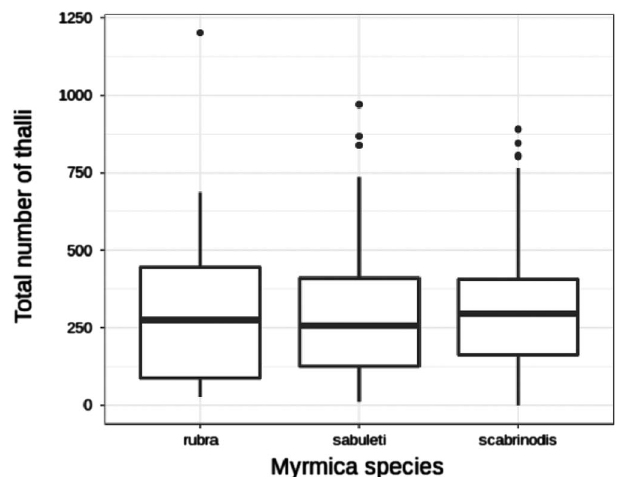
Figure 4. Total number of thalli on worker bodies of the three examined Myrmica species ( n = 34 for M. rubra , n = 50 for M. sabuleti , n = 270 for M. scabrinodis ).